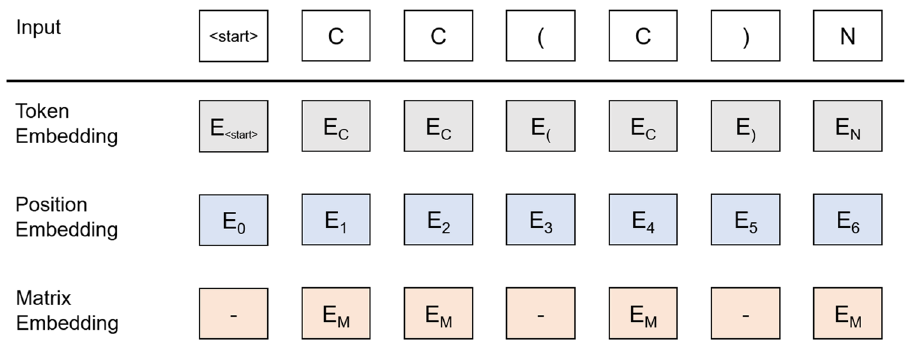
Figure 2. The input representation of SMILES. The input is the sum of the token embeddings, the position embeddings, and the matrix embeddings. The matrix embedding is only applied to atomic